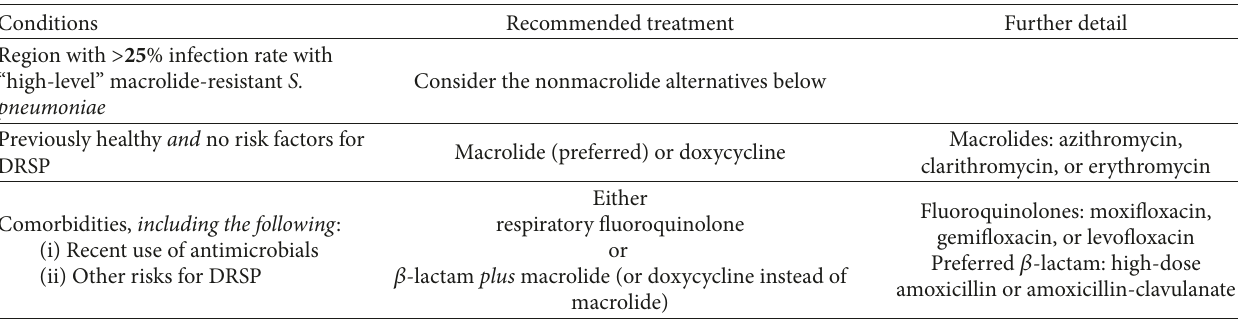
Table 5: Summary ∗ of 2007 IDSA/ATS guidelines for outpatient treatment of community-acquired pneumonia [4]. Conditions Recommended treatment Region with > 25 % infection rate with “high-level” macrolide-resistant S.